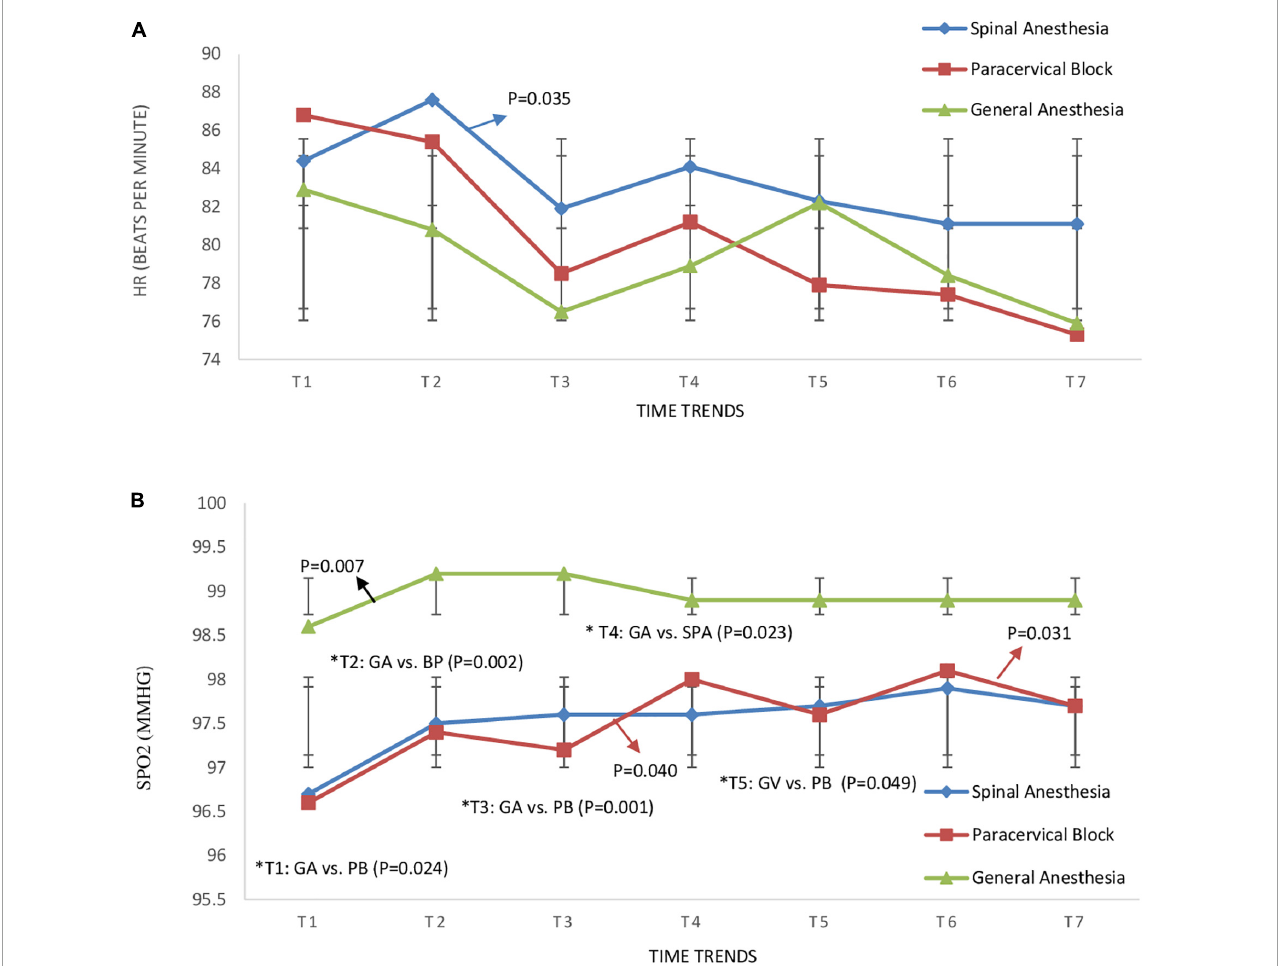
FIGURE3 Time trend changes in panel (A) heart ratio (HR) (beats per minute) and (B) oxygen saturation (SPO 2 ) (mmHg) in three groups of study. Time trends as follows; T1: pre-anesthesia, T2: during-anesthesia, T3: during-tenaculum, T4: during-cervical dilation, T5: during-hysteroscopy, T6: during-biopsy, and T7: during-hysteroscopy removal. The P -value within group differences are indicated by arrows and between groups by ∗ . SPA, spinal anesthesia; PB, paracervical block; GA, general anesthesia.